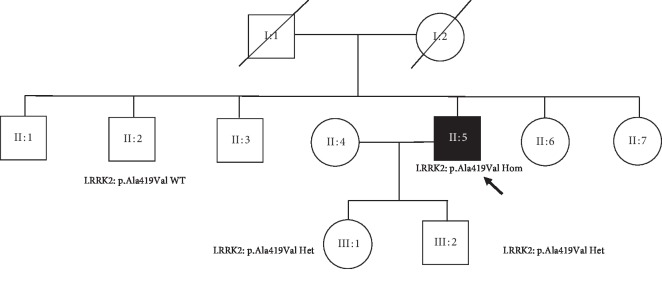
Homozygous p.Ala419Val proband and his family tree.